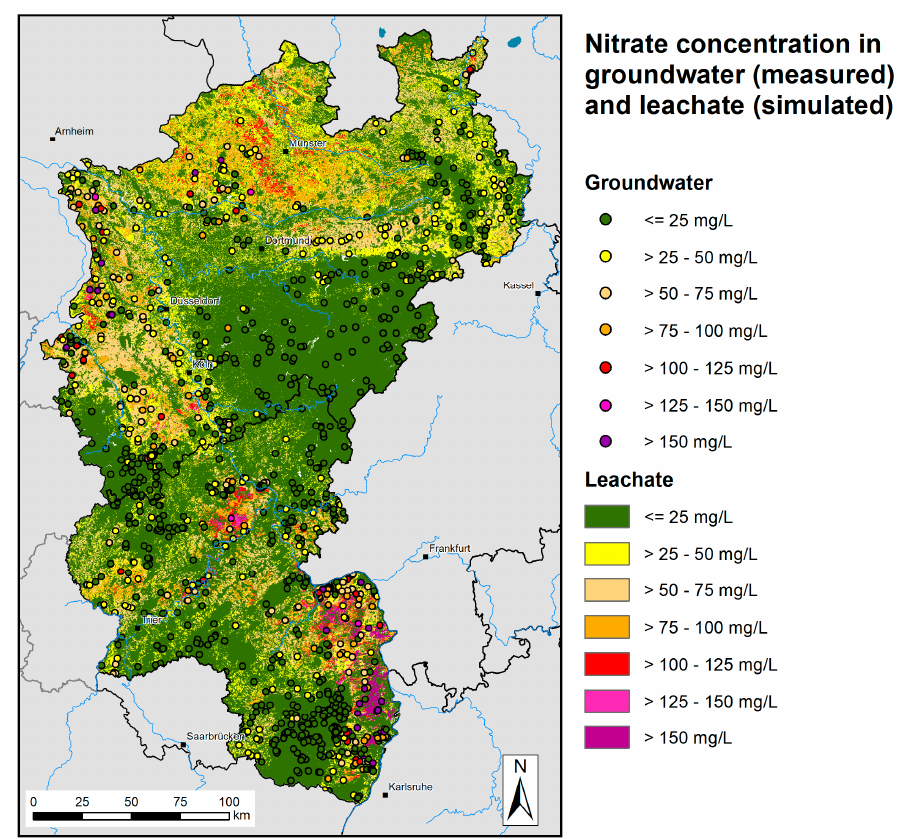
Figure 6. Spatial representation of class widths of modelled nitrate concentrations in leachate with measured nitrate concentrations in groundwater in the Federal States of NRW and RLP. Water 2021 , 13 , x FOR PEER REVIEW